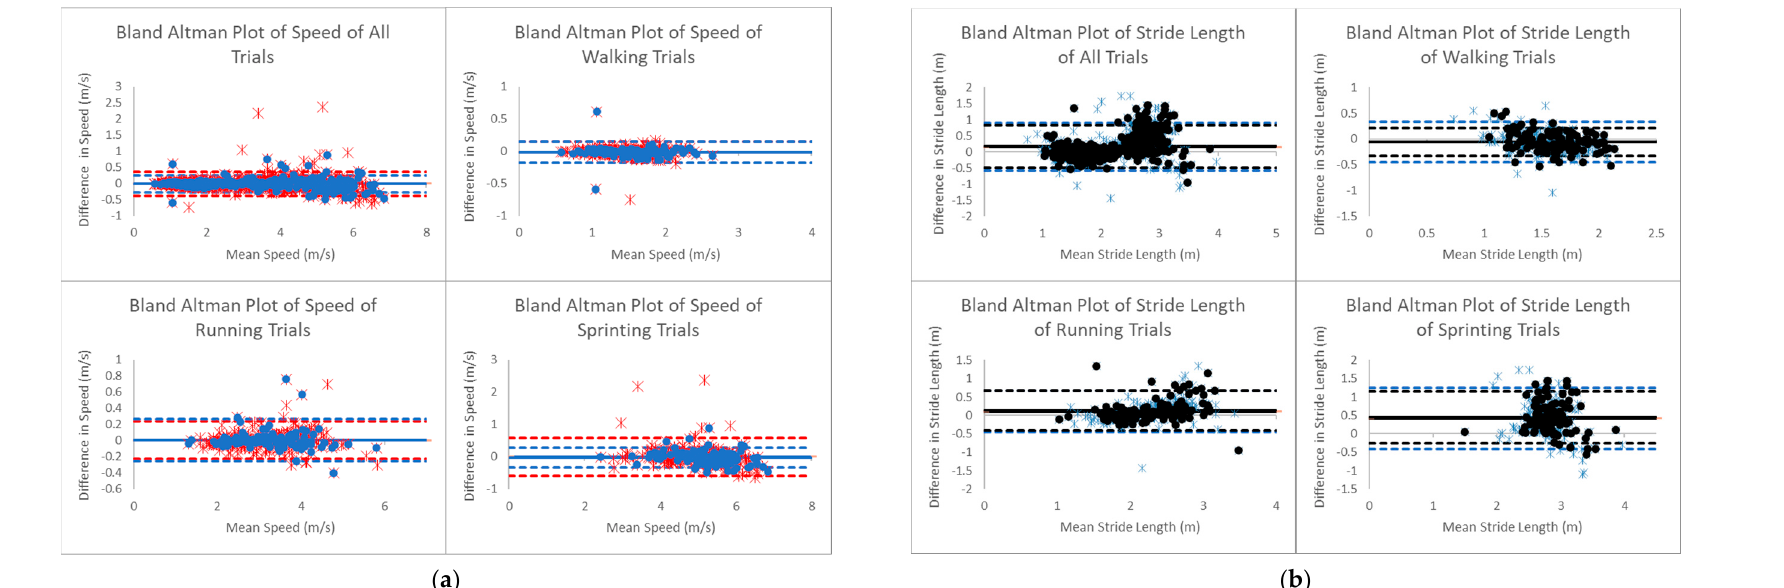
Figure 3. ( a ) Bland–Altman plot of speed comparing difference (MOCAP minus ultrawide bandwidth LPS) and mean. Red stars and red dashed lines (±1.96 SD from the bias line) represent a dataset where anomalies are not removed. Dark blue dots and dark blue dashed lines represent a dataset where anomalies are removed. ( b ) Bland–Altman plot of stride length comparing difference (MOCAP minus ultrawide bandwidth LPS/IMU) and mean. Light blue stars and light blue dashed lines represent a dataset where anomalies are not removed. Black dots and black dashed lines represent a dataset where anomalies are removed.